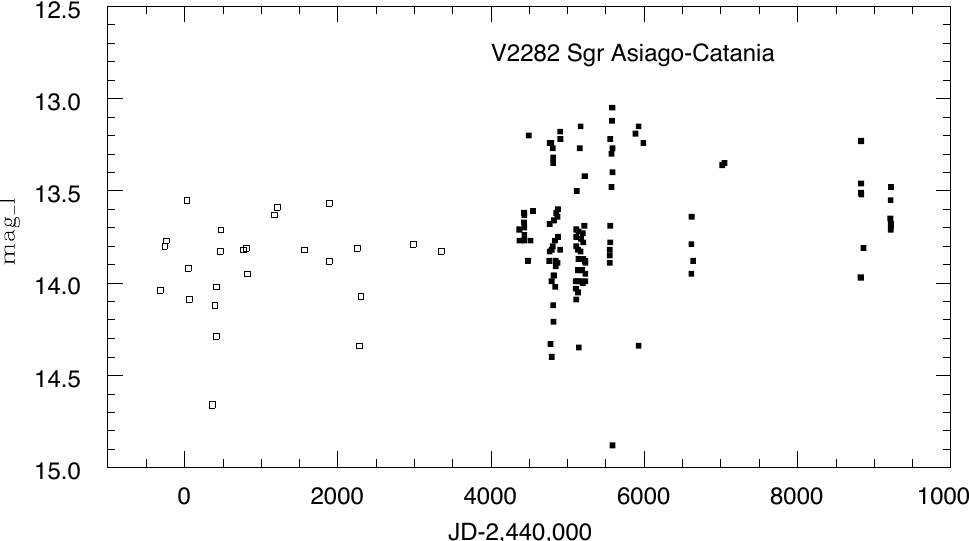
Figure 2: Light curve in the I photographic band of V2282 Sgr from the Asiago (open squares) and Catania (filled squares) archives. Due to its southern sky position the coverage shows a marked seasonal